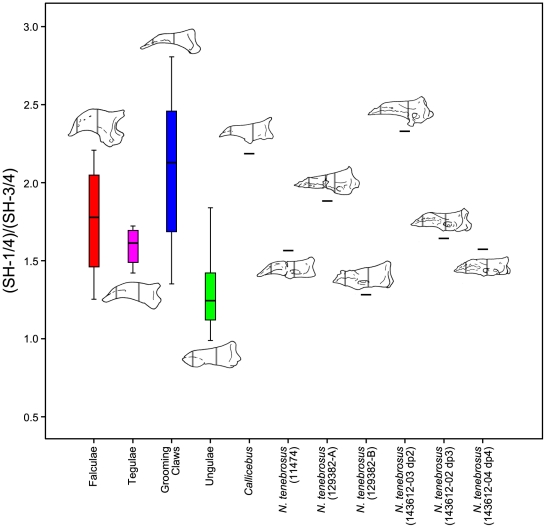
Boxplot of ratio of distal phalanx proximal shaft height to distal shaft height.Proximal height (SH¼) is measured at a point along the shaft of the phalanx that is ¼ of the distance from the proximal end to the tip, distal height (SH¾) at ¾ the distance. The median specimen from each extant group is illustrated: falculae - Phalanger orientalis; tegulae - Callithrix sp.; grooming phalanges - Nycticebus coucang; ungulae - Chlorocebus aethiops. See Materials and Methods for measurement descriptions.